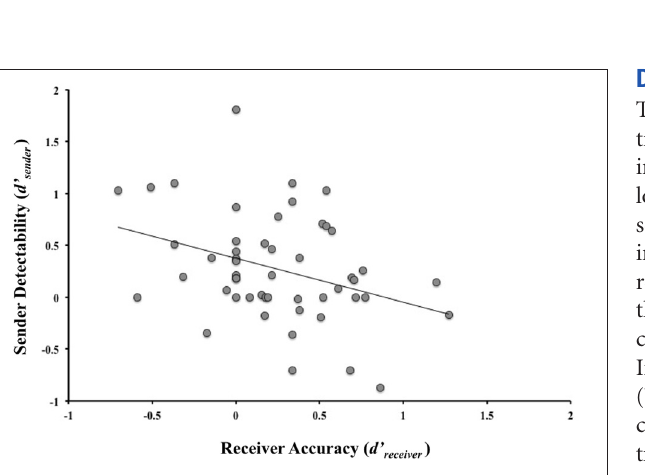
of the veracity of their statements (Spearman’s rho = − 0 .